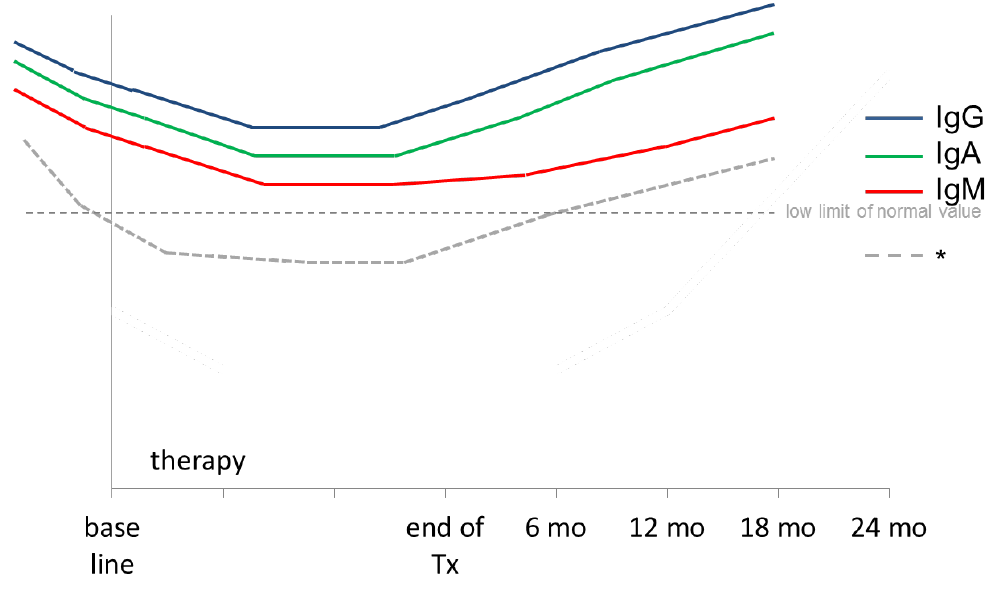
Figure 2. Schematic presentation of immunoglobulin levels in NHL patients treated with rituximab. Hypogammaglobulinemia observed in 40%–50% of patients after rituximab therapy